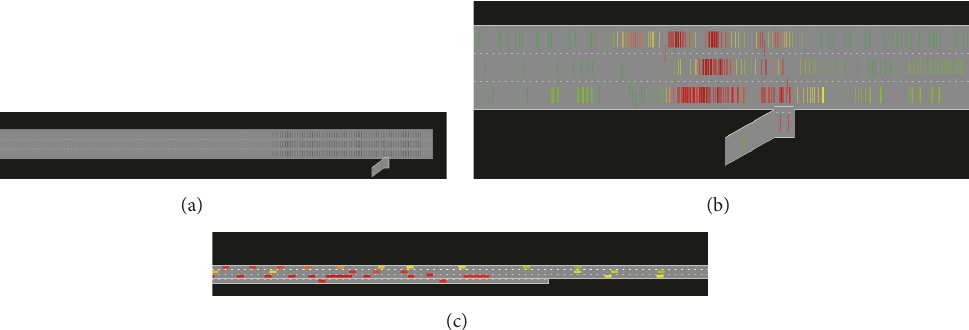
Figure 4: (a) Road corridor for model experiment with detector locations. (b) Exploded view of traffic flow; (c) detailed view of traffic at the bottleneck.